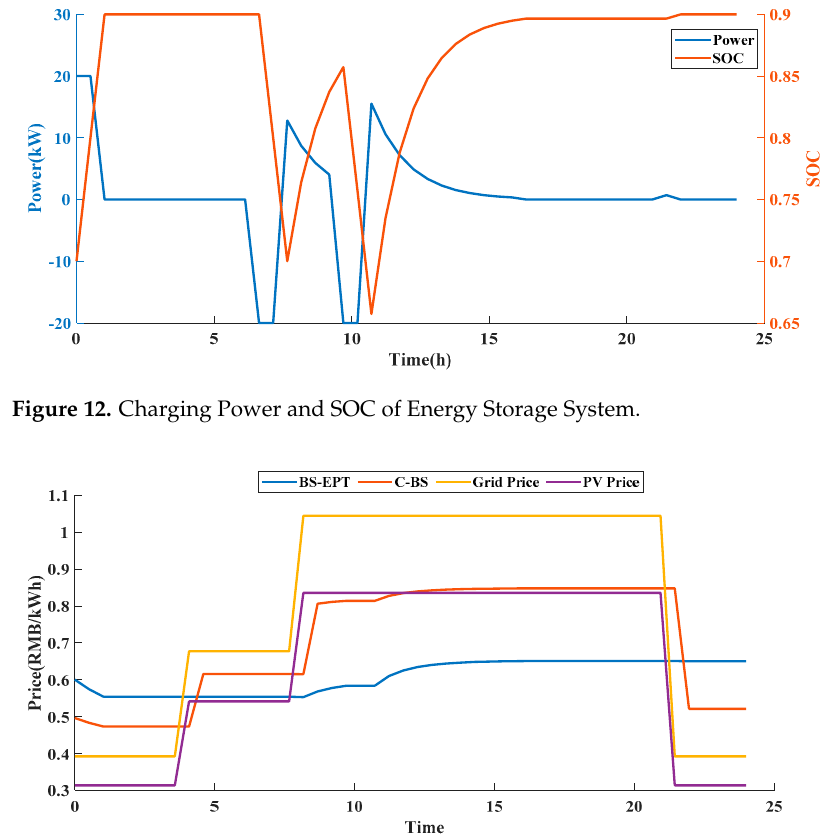
Figure 13. EPT and sell price of Energy Storage System.